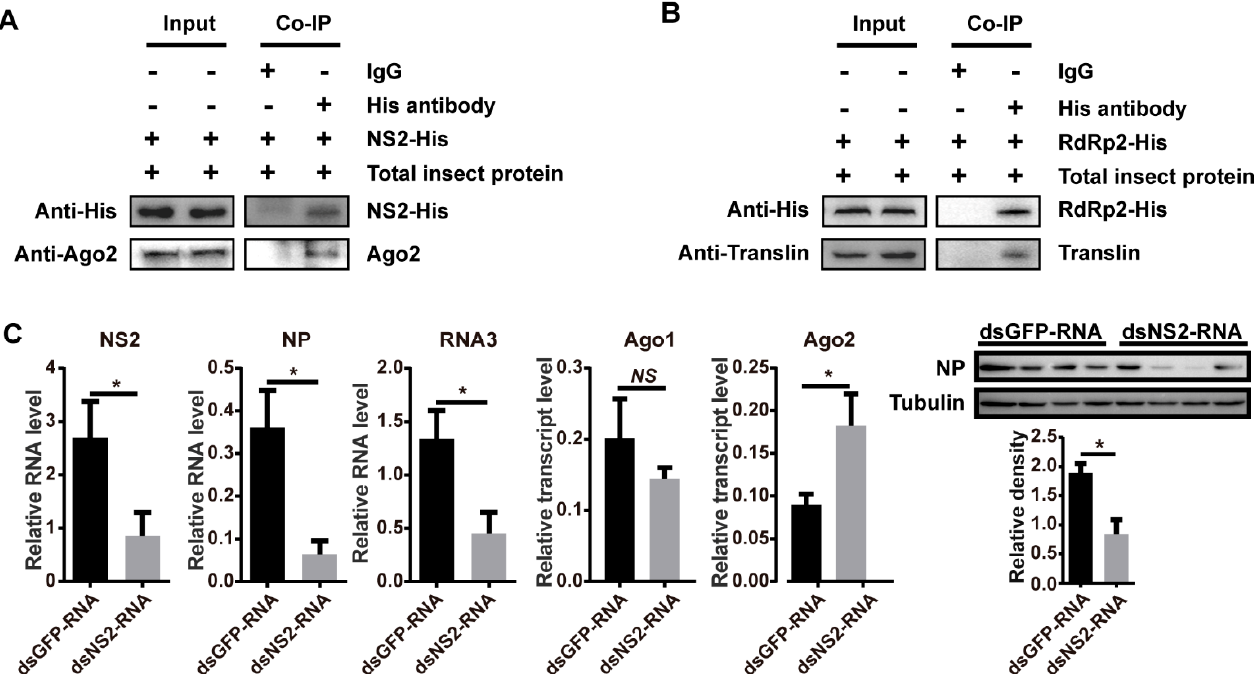
Figure 4. Regulation of RNAi pathways through insect protein-viral protein interactions. ( A ) Coimmunoprecipitation (Co- IP) assay demonstrating that the recombinant expressed NS2-His pulled down Ago2 from the crude extracts of viruliferous planthoppers. ( B ) Co-IP assay demonstrating that the recombinant expressed RdRp2-His pulled down Translin from the crude extracts of viruliferous planthoppers. Monoclonal antibodies against Ago2 and His and polyclonal antibodies against Translin were applied. IgG was used as a negative control. ( C ) Effect of planthopper Ago1 and Ago2 transcript levels and viral NS2 , NP, and RNA3 levels in the planthoppers at 6 d after injection of double-stranded RNAs (dsRNAs) of NS2 with RSV crude preparations. The control group was injected with ds GFP -RNA and RSV crude preparations. The relative transcript or RNA levels to that of EF2 were quantified with quantitative real-time PCR. The protein levels of NP and tubulin were measured using monoclonal anti-NP and anti- β -tubulin antibodies by western blot. Four biological replicates were shown for each group. The relative grayscale of NP to that of tubulin was quantified and compared between the gene interference group and ds GFP -RNA injection groups. The values represent the means ± SEs. *, p < 0.05. NS, no significant